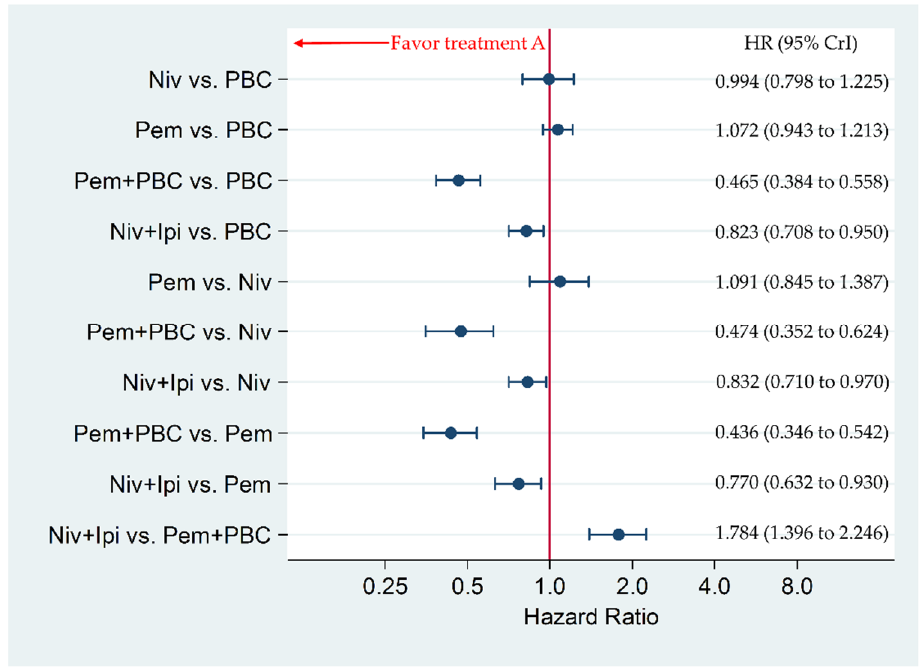
Figure 3. Comparative efficacy for progression-free survival (PFS) among five therapeutic regimens (Niv+Ipi, Pem+PBC, Pem, Niv, PBC) in patients with programmed cell death ligand 1 (PD-L1) expression levels of 1% or more. Comparisons were expressed as Treatment A versus Treatment B. Data are expressed in terms of hazard ratio (HR) and 95% credible intervals (CrIs); Niv, nivolumab;